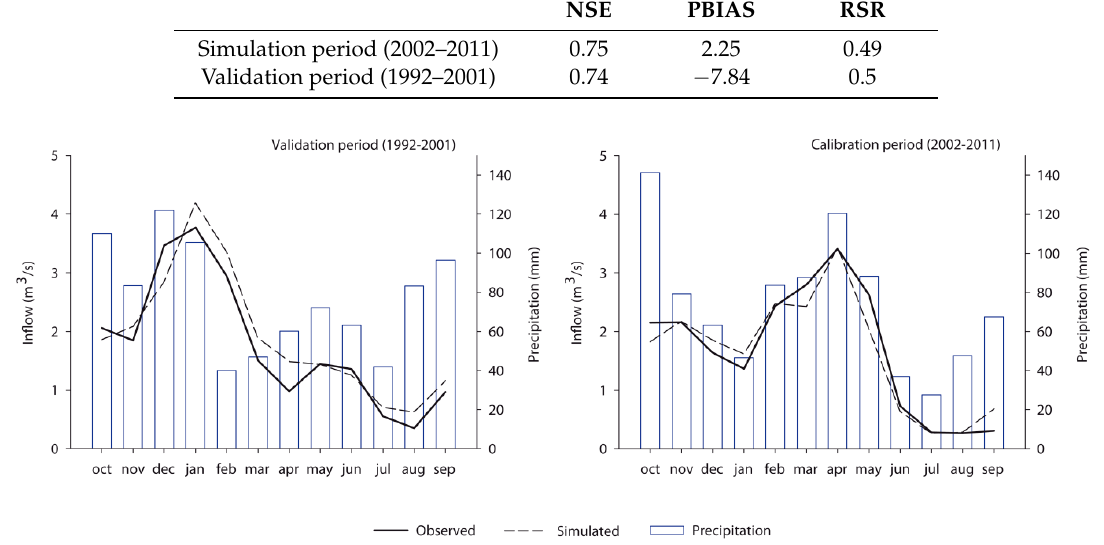
Figure 5. Simulated (grey) and observed (black) monthly streamflow after parameter calibration. Table 3. Statistics obtained for calibration and validation periods.